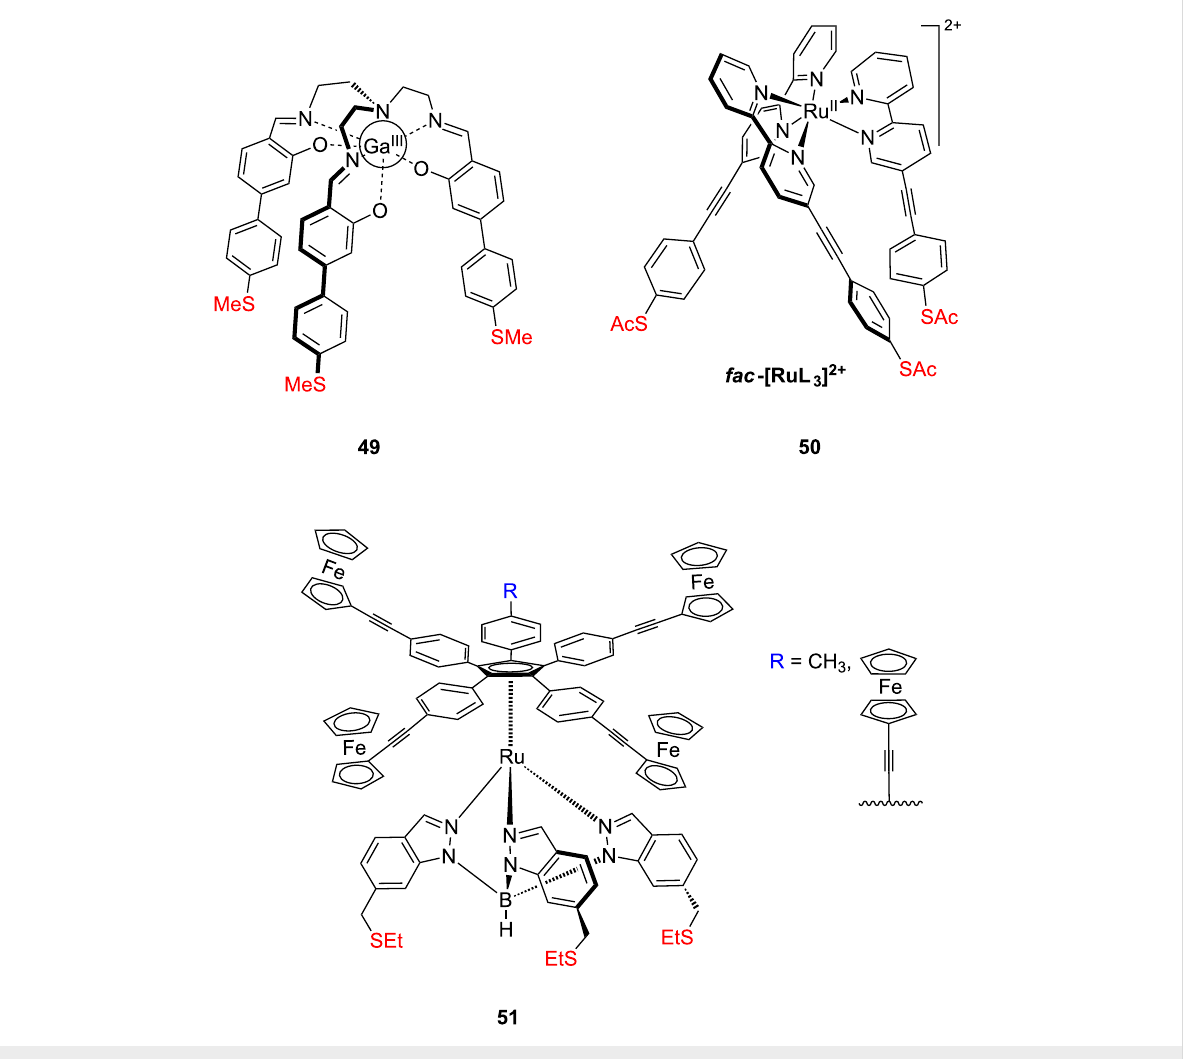
Figure 27: Organometallic tripodal scaffolds 49–51 .